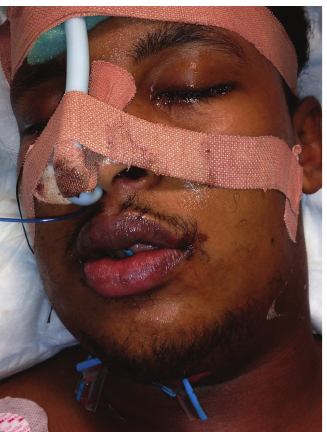
Figure 2: Patient intubated with drains in the Intensive Care Unit.